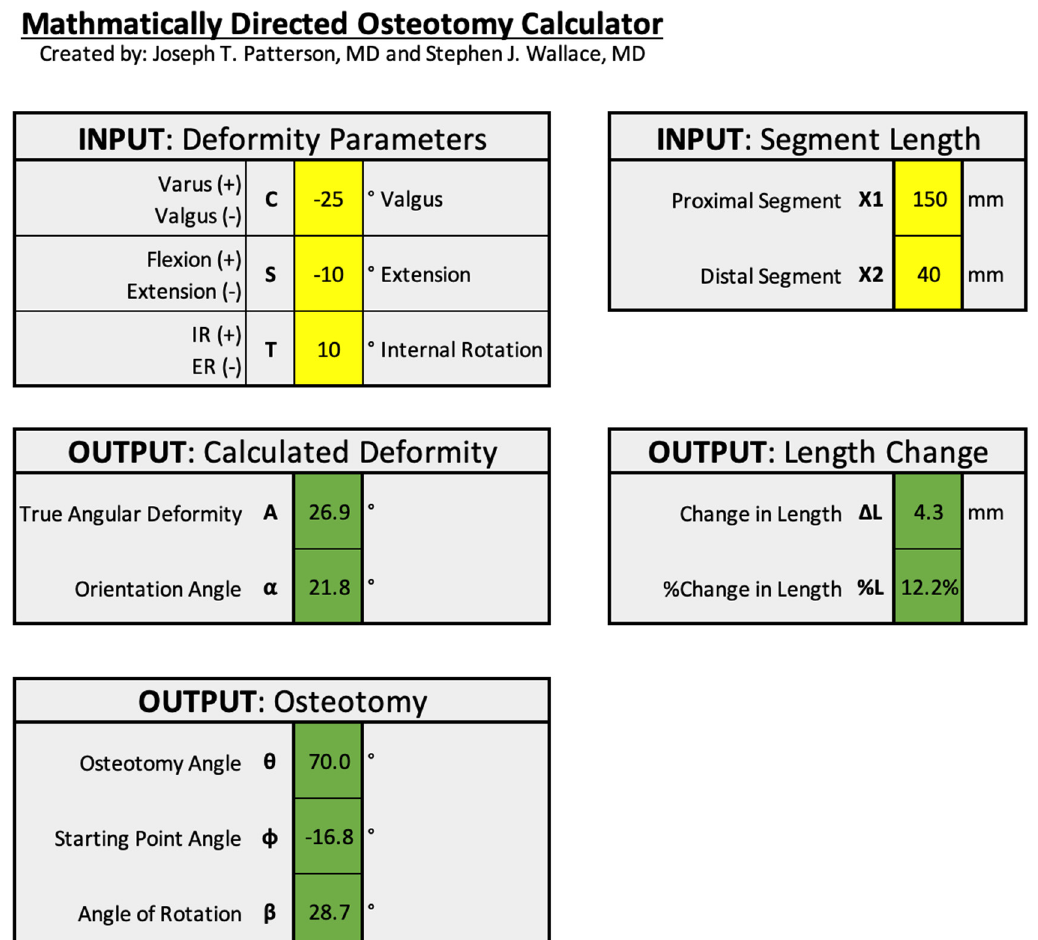
Figure 9. An example of the mathematically derived osteotomy calculator. This tool was developed for ease of use and improved accuracy and precision for MDO planning. Additionally, the program digitally plots the results in a similar format to the original graphs (as seen in cases 1 and 2).